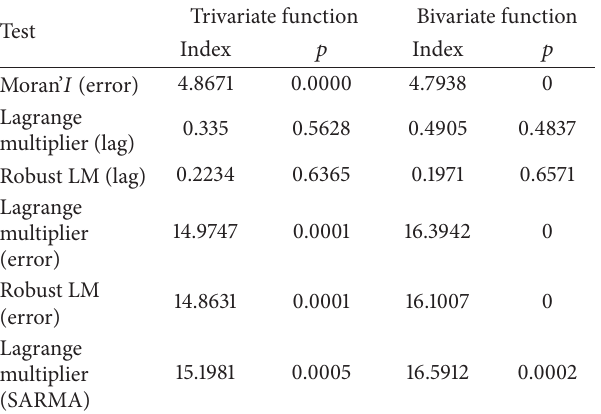
Table 3: Space correlation OLS test based on space weight matrix 𝑊 Queen 1